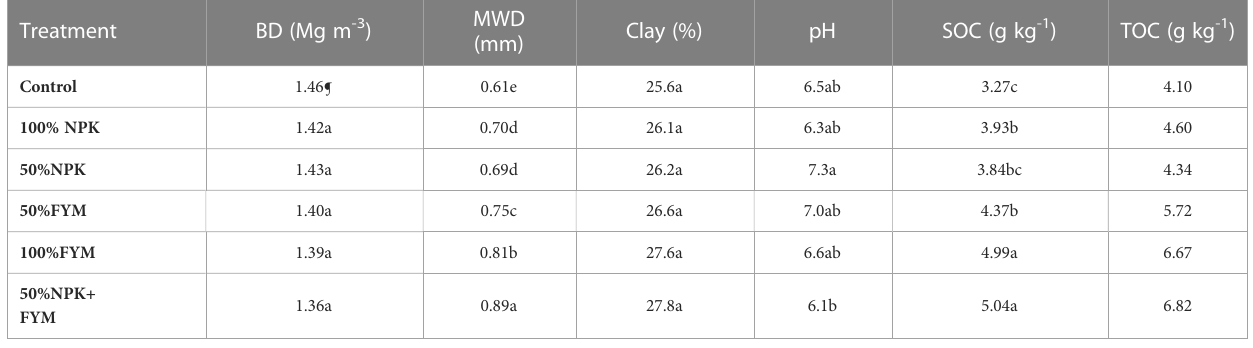
TABLE 1 Effect of long-term fertilization and manuring on soil physical and chemical properties.